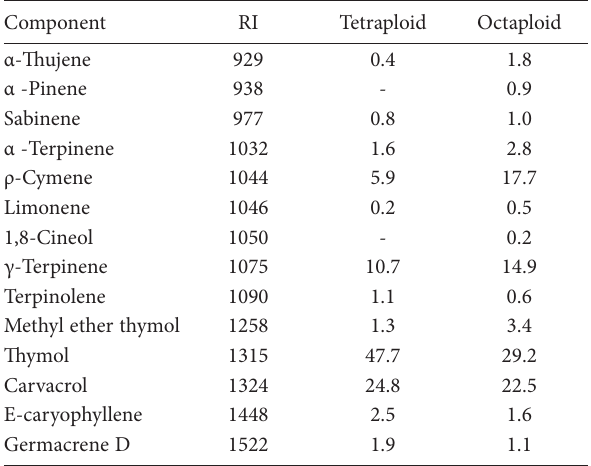
Table 4. Comparison between tetraploid and octaploid components of essential oils resulted by GC, and GC-MS.